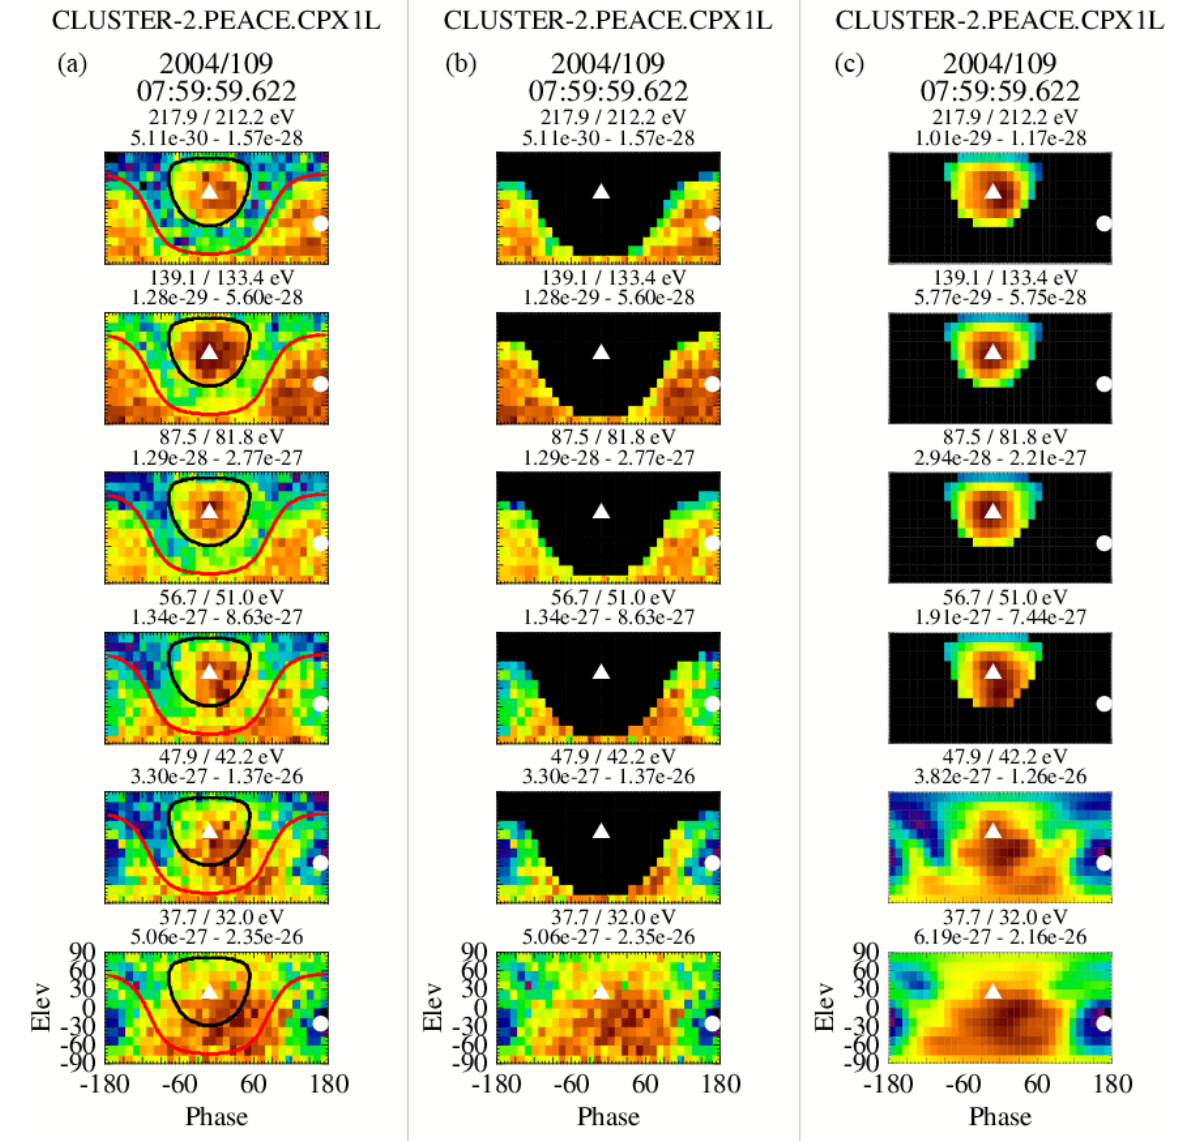
Figure 1. A set of three columns of φ – θ plots illustrating the use of phase space masks to isolate various electron populations. Panel (a) shows a set of plots with no masking. The black and red traces are lines of constant pitch angles of 120 and 80 ◦ . Panel (b) masks out all pitch angles greater than 80 ◦ and at energies greater than 37.7eV, leaving just the return electrons. Panel (c) masks out all pitch angles less than 120 ◦ and at energies greater than 47.9eV, leaving just the strahl electrons. The solid triangle and dot in the plots are the projections of the tail and head of the magnetic field